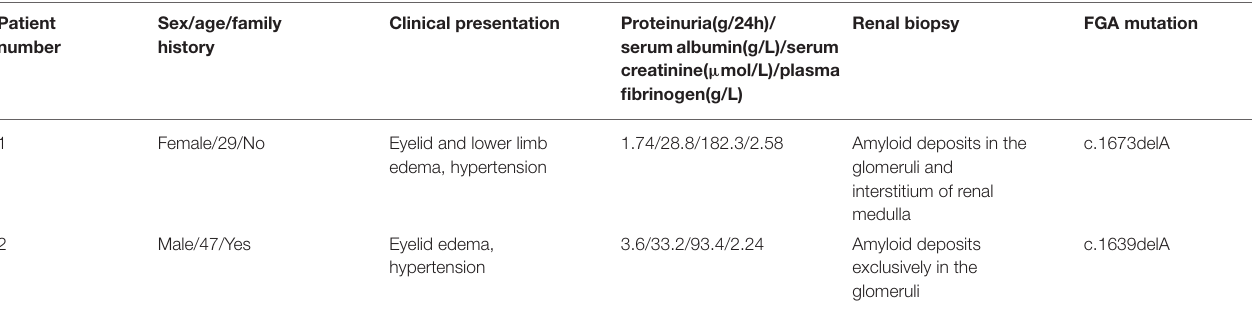
TABLE 1 | Clinical presentation and laboratory findings of the